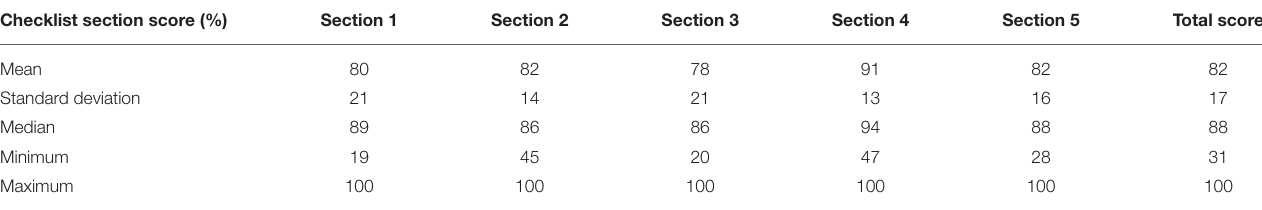
TABLE 2 | The average performance of the 84 laboratories from the African region audited between April–December 2021 in the 5 sections of the checklist,